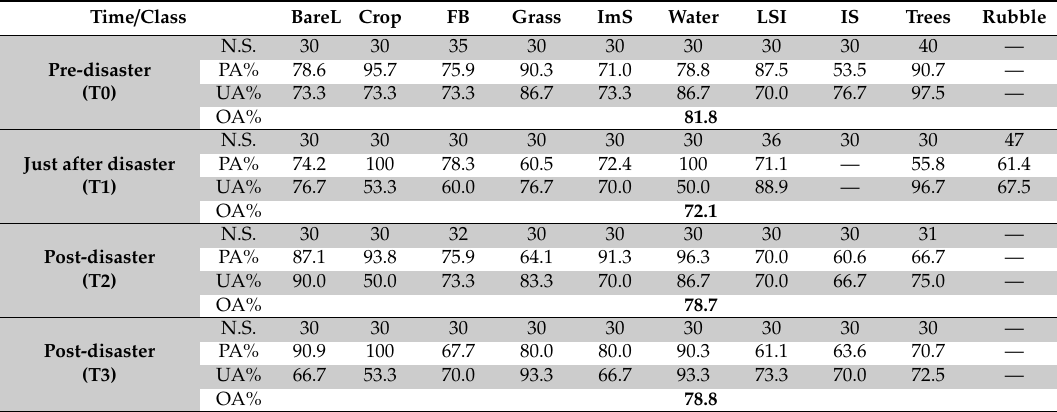
Table 5. The LU classification accuracies for T0, T1, T2, and T3 for Barangay 69. User’s and producer’s accuracies and corresponding errors were computed across the study area from the confusion matrices. BareL: bare land; FB: formal built-up area; ImS: impervious surface; LSI: large scale industry; IS: informal settlement; PA—producer’s accuracy; UA—user’s accuracy; OA—overall accuracy; N.S.—number of samples used for the accuracy assessment. Time / Class BareL Crop